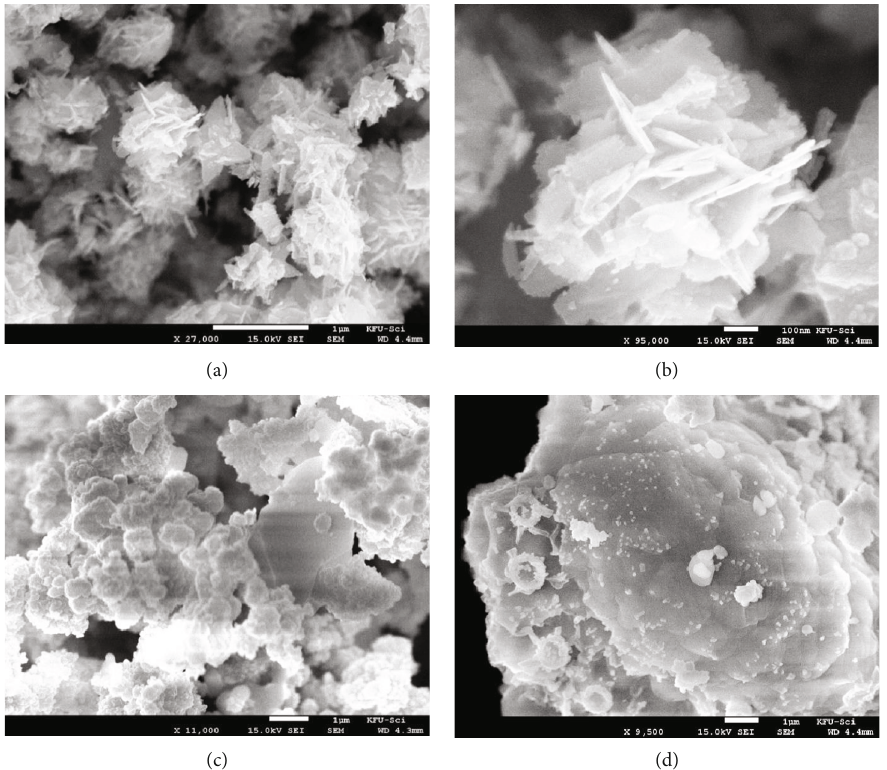
Figure 1: (a) Scanning electron microscopy images of as-prepared Zn-layered double hydroxide (LDH) clay powder (LDH75). (b) High- resolution electron microscopic image of the LDH75 sample. (c) The e ff ects of heating (250 ° C) on the LDH sample, which compacted into clusters of layered double oxide (LDO) layers. (d) Electron microscopic image of a sizeable layered region of the LDO